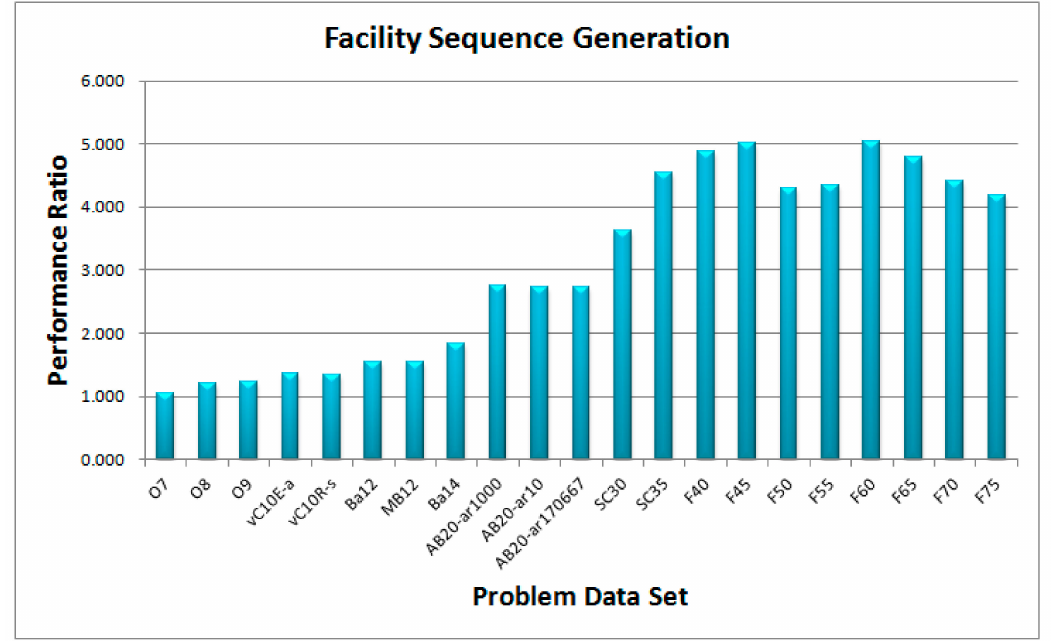
Figure 6. Performance ratio between INI_FS2 and INI_FS1 for facility sequence